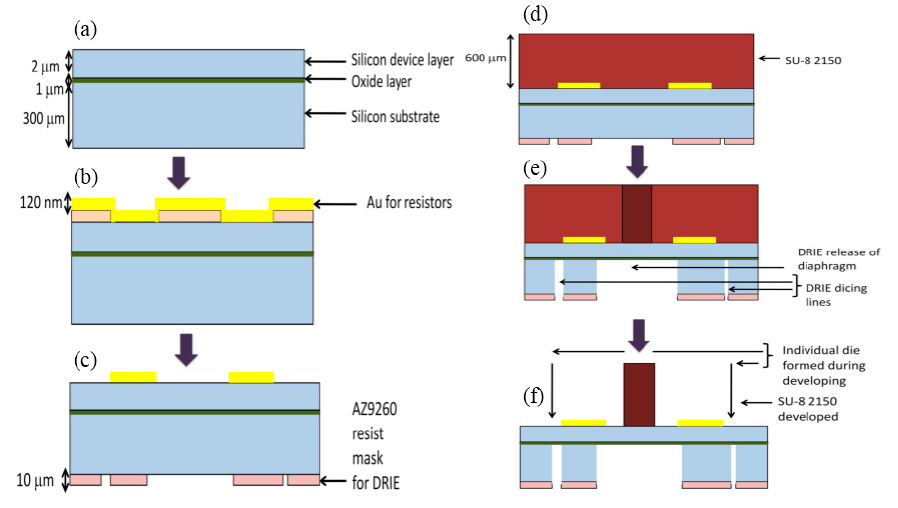
Figure 4. Biomimetic sensor fabrication: ( a ) SOI wafer structure; ( b ) Resist patterning followed by gold sputtering; ( c ) Lift-off process and backside resist patterning for DRIE mask; ( d ) SU-8 2150 spin-coated on top side; ( e ) SU-8 patterning and DRIE through-holes on backside of wafer; ( f ) SU-8 developing to form standing pillar.